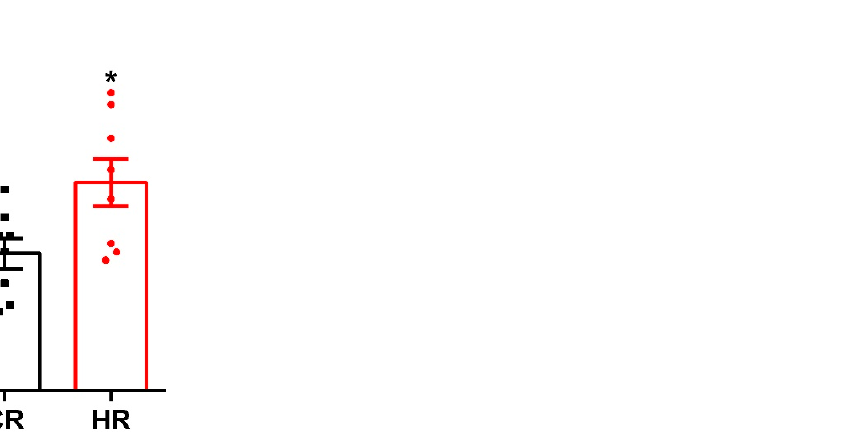
6 of 14 Figure 2. Morphometric parameters of liver mitochondria from experimental rats. ( A ) A histogram of distribution of the mitochondrial area in the groups. ( B ) A histogram of distribution of the mito-